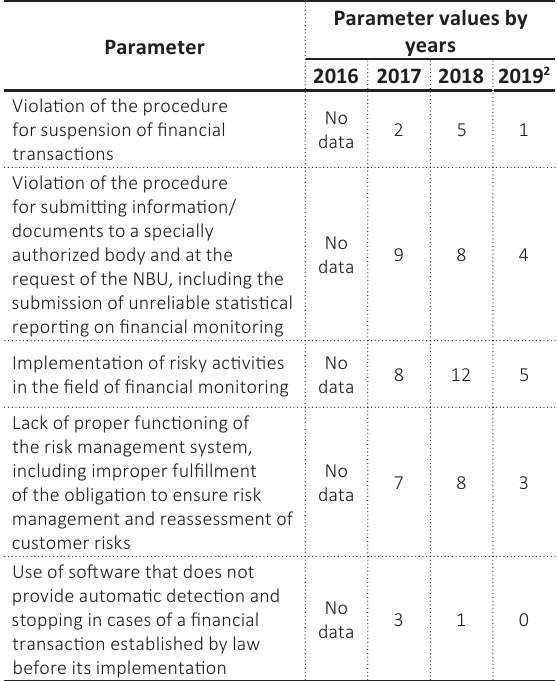
Table 1 (cont.). Generalized information on inspections of banks by the NBU and enforcement measures applied to them